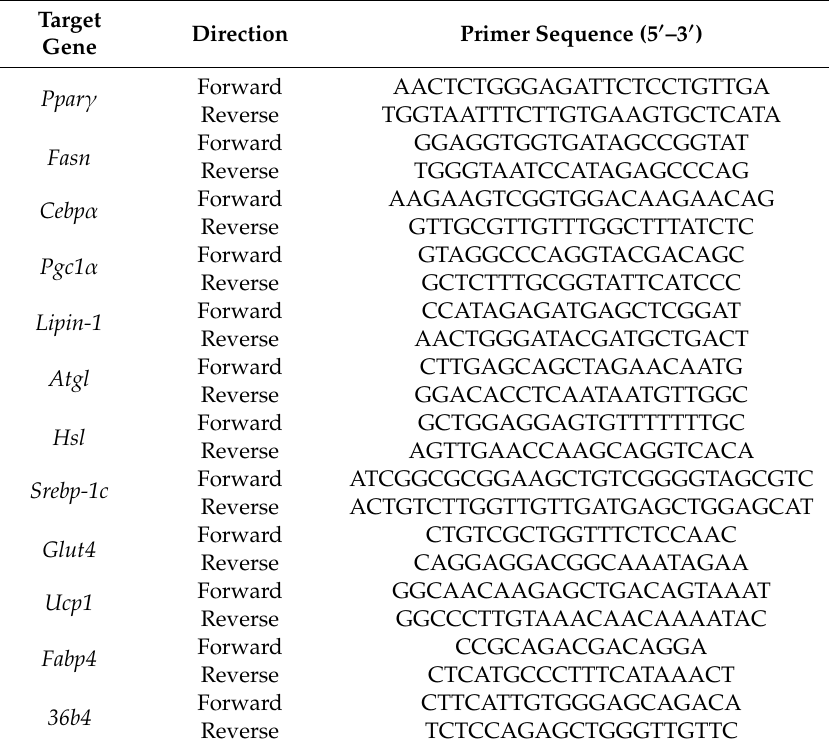
Table 1. Primer sequences for real-time reverse transcription